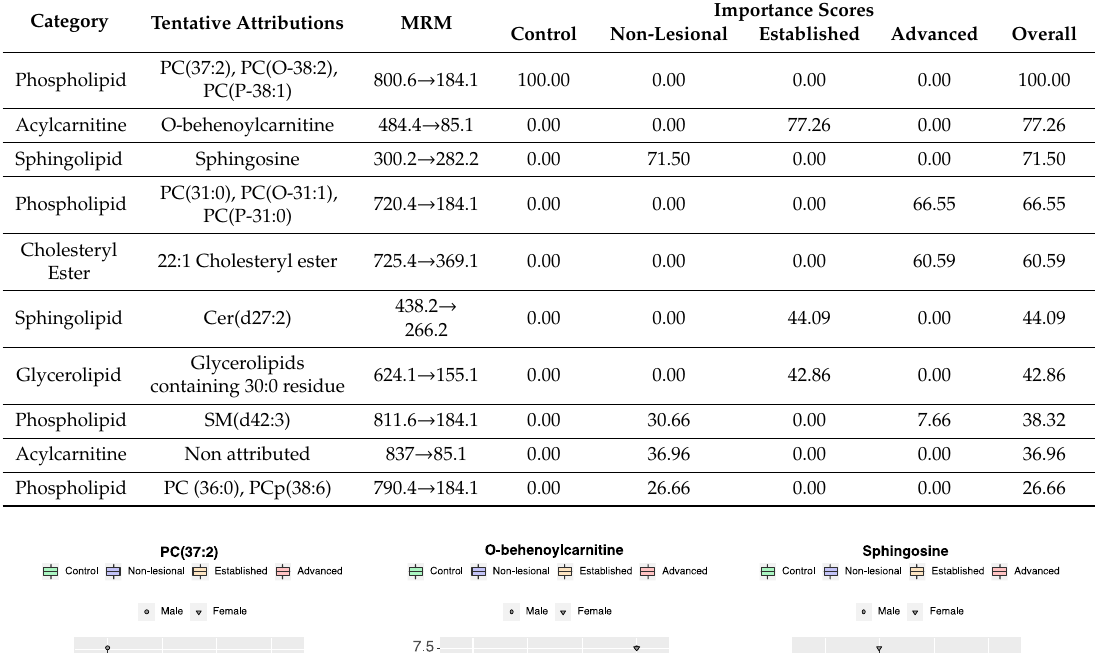
Table 3. List of top 10 lipid ions ranked by importance score for prediction of disease progression in the elastic net model.